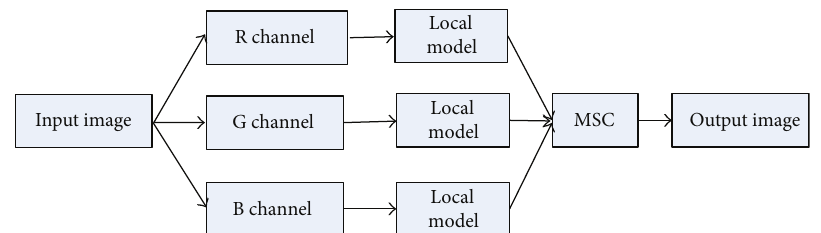
Figure 1: Flowchart of the proposed method.